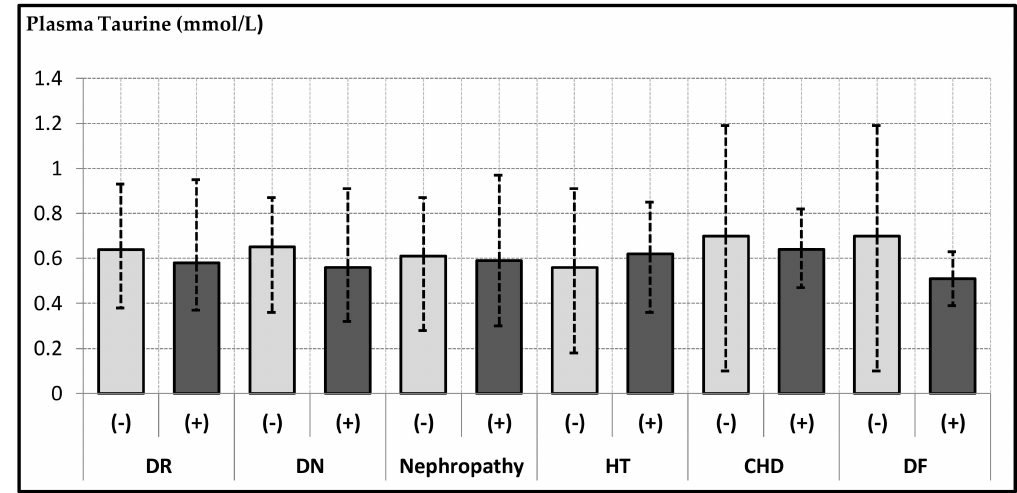
Figure 1. Relationship of plasma taurine levels with diabetic complications in diabetic subjects. DR: diabetic retinopathy; DN: diabetic neuropathy; HT: hypertension; CHD: coronary heart disease; DF: diabetic